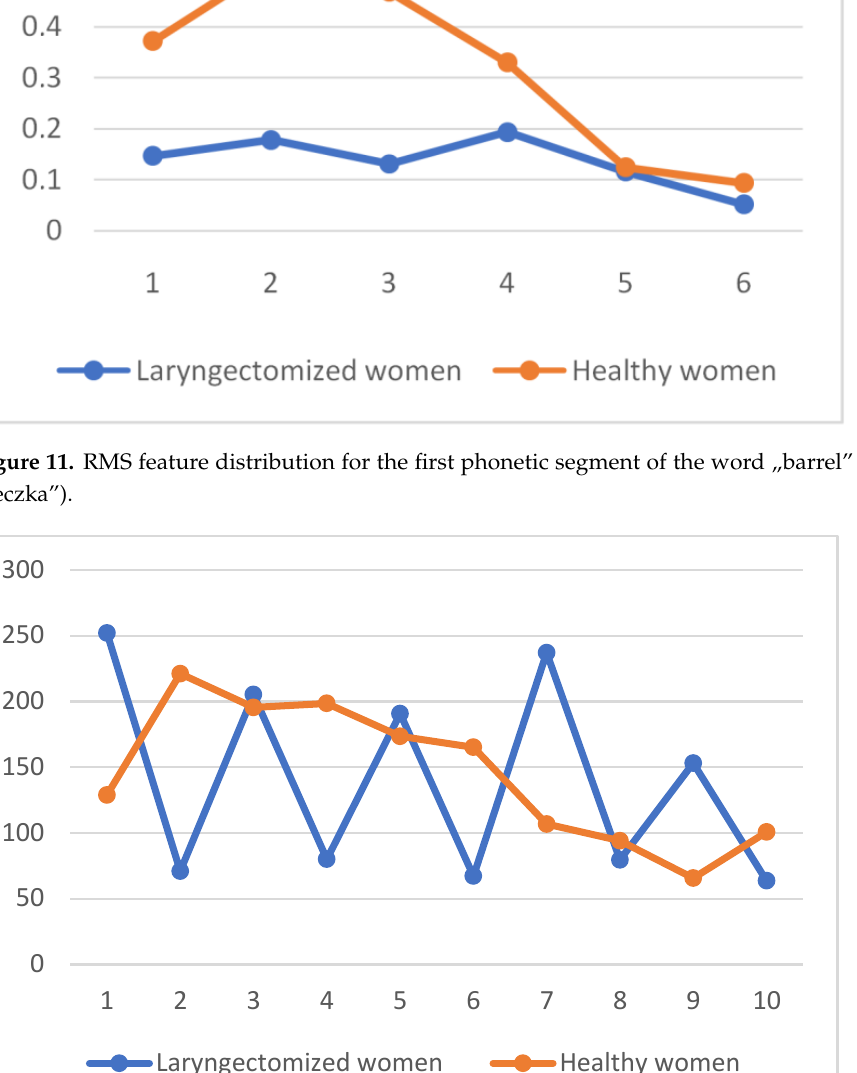
Figure 12. Br features distribution for the first phonetic segment of the word „barrel” (in Polish